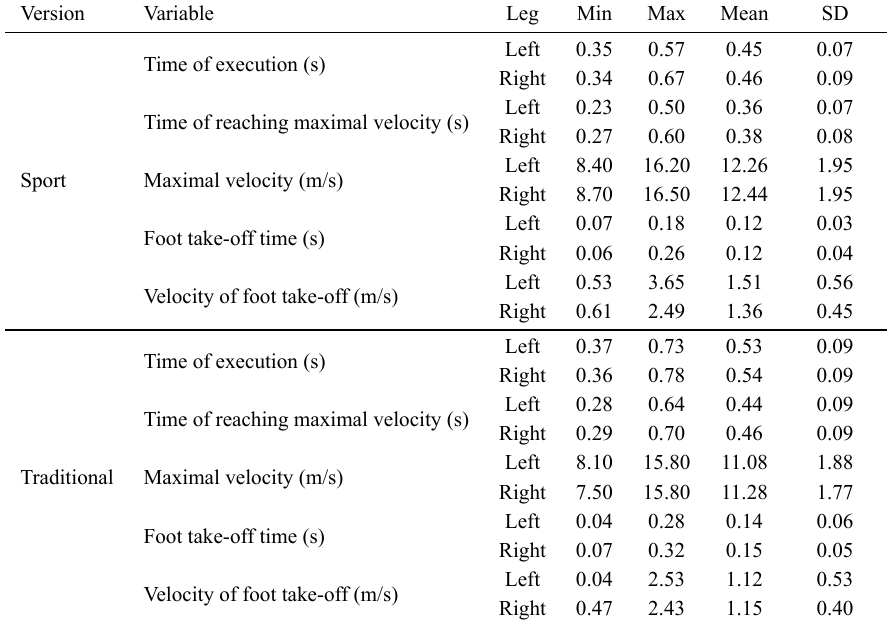
Table 2. Descriptive statistics of kinematic indicator values with division for both kicking legs and